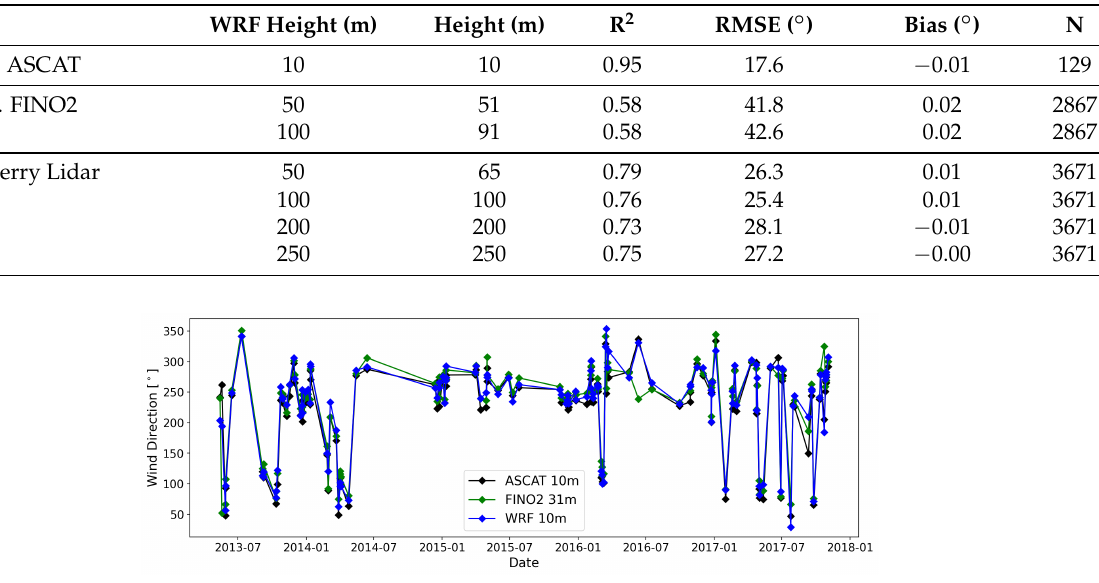
Figure 7. Wind direction timeseries of FINO2, ASCAT, and WRF at the FINO2 location from 2013 to